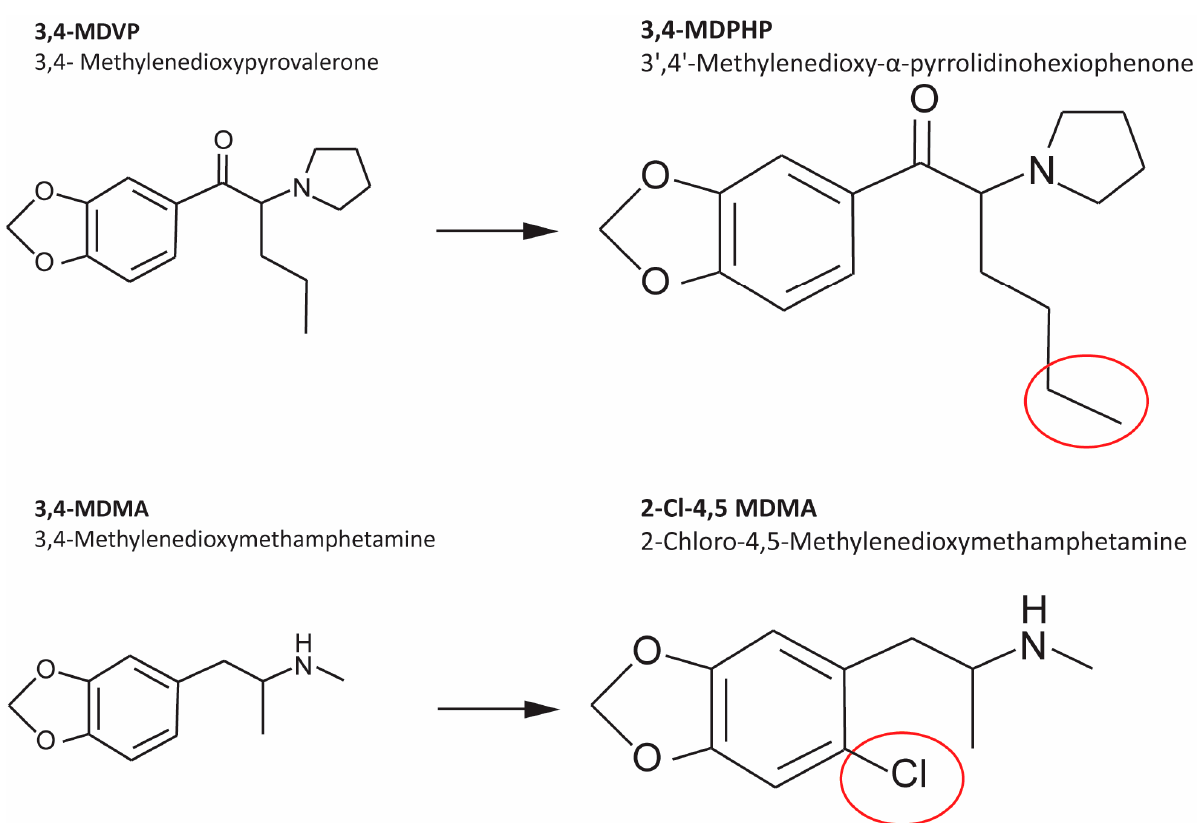
Figure 1. Chemical structures of 3,4-MDVP, 3,4-MDPHP, 3,4-MDMA, and 2-Cl-4,5-MDMA.